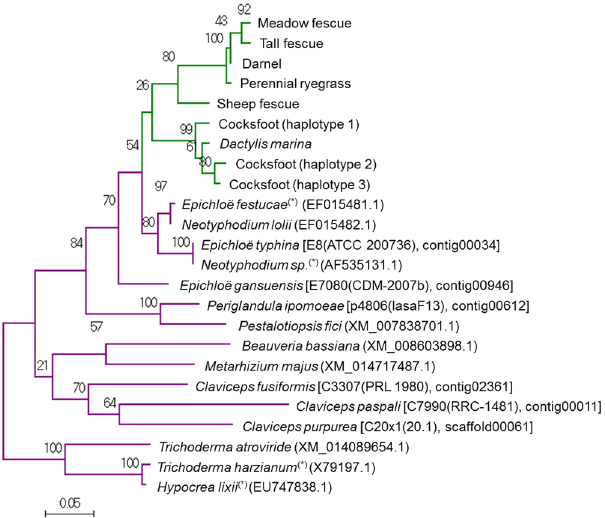
Figure 4. Phylogenetic tree of Lp BGNL orthologues and fungal ß-1,6-glucanase genes. The phylogram was generated based on amino acid sequence of the aryl-phospho-beta-D-glucosidase domain, and sequences from angiosperm and fungi species are indicated with green and purple, respectively. Asterisk ( * ) denotes species from which gene products have been confirmed to have the ß-1,6-glucanase activity. For cocksfoot, three contigs (haplotypes 1–3) were generated, and amino acid sequences from those contigs were used. For Dactylis marina , the contig without a putative premature stop codon was used. Strain and sequence contig (scaffold) identifiers of the Genome Project at the University of Kentucky website are shown in brackets. For the other fungi sequences, NCBI UI is shown in bracket. The clade including the sequences from Trichoderma and Hypocreaas species were selected as an outer group to obtain a root of the phylogenic tree. A figure legend generated with the MEGA7 software can be found in Supplementary Note